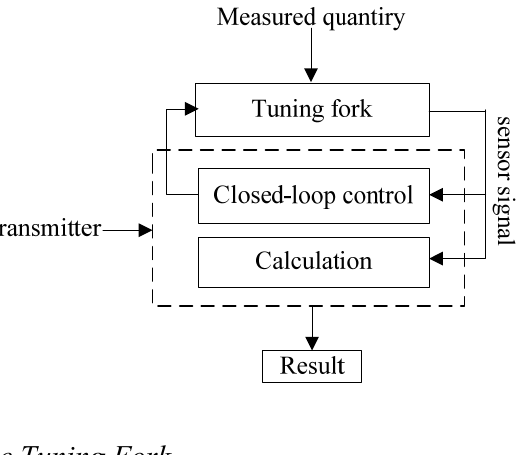
Figure 1. Schematic of the resonant tuning fork liquid density measurement